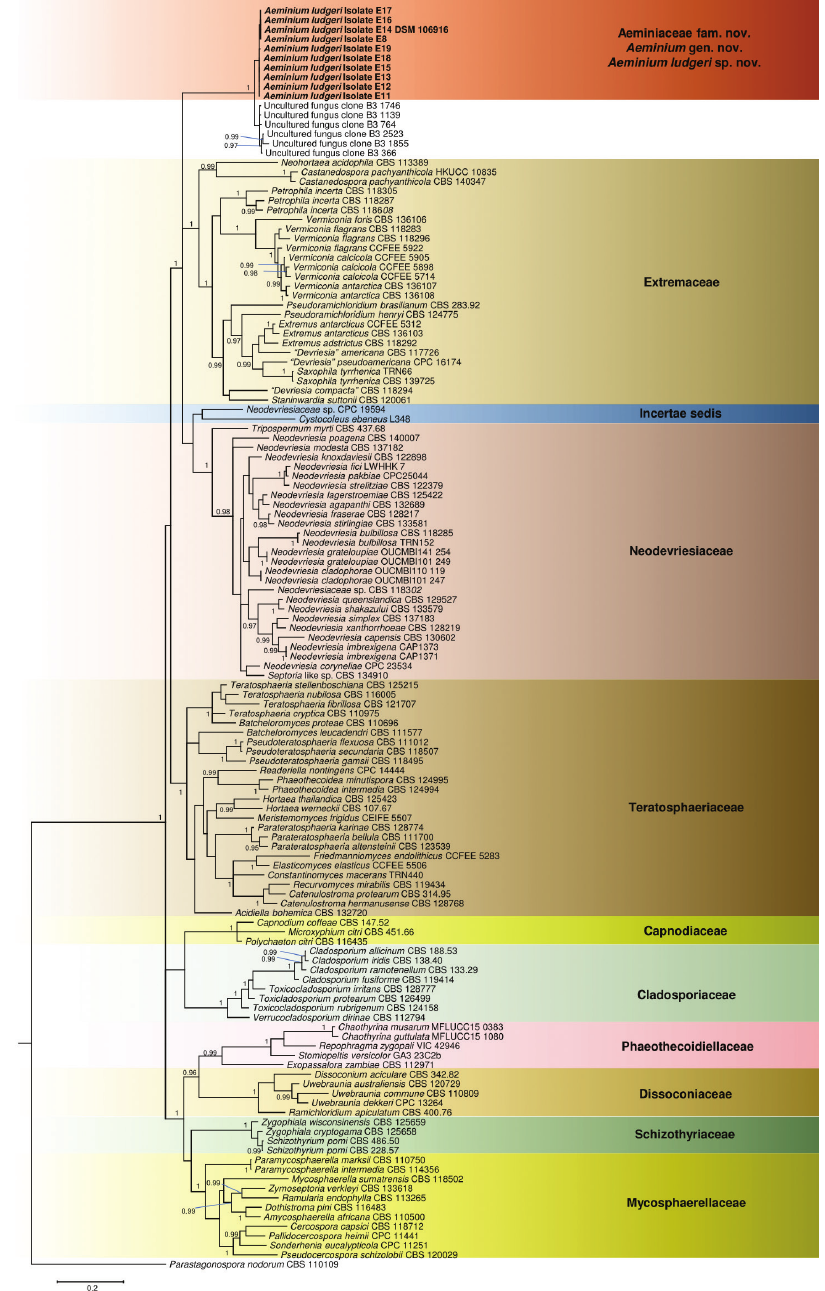
Figure 1. Bayesian 50% majority rule consensus tree based on an LSU/ rpb2 /ITS concatenated align- ment, containing representative sequences from the order Capnodiales. The new strains are shown in bold. Bayesian posterior probabilities (PP) ≥ 0.95 are presented at the nodes. The tree was rooted to Parastago- nospora nodorum CBS 110109. The scale bar specifies 0.2 expected changes per